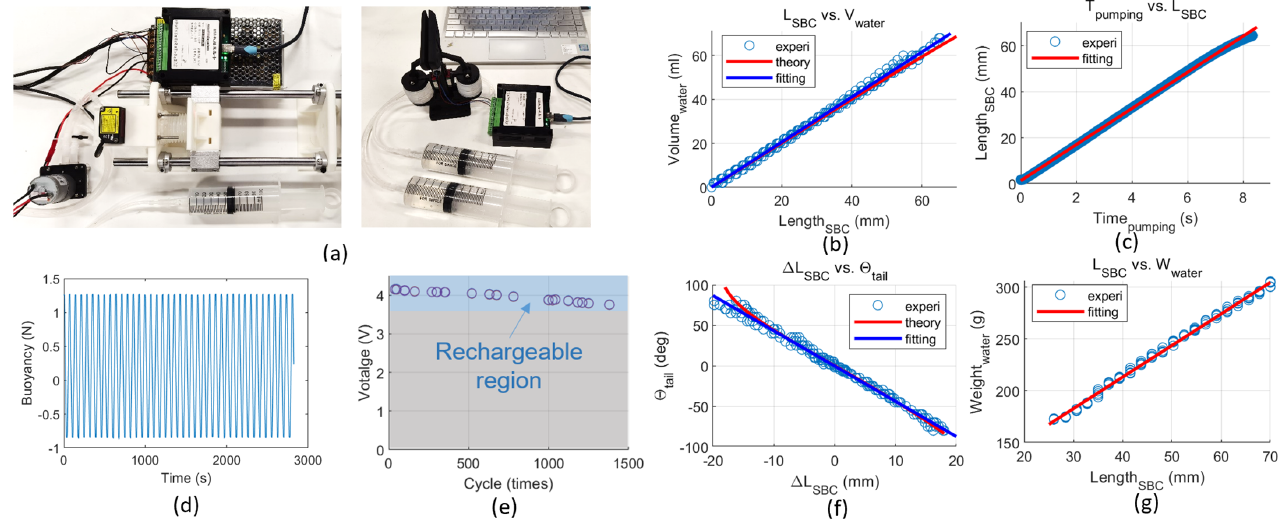
Figure 5. Bench test results, with the test apparatus, energy consumption test, and SBC actuator test results, as well as the tail MCM-II test, shown. ( a ) Bench test apparatuses. The left one is used to explore the relationship between the length of the SBS (L SBC ) and volume of the contained water (V water ), pumping time (T pumping ), and weight of the contained water (W water ). The results are shown in subfigures ( b ), ( c ), and ( g ), respectively. The right one was used to explore the relationship between the change of the length of SBC ( ∆ L_SBC) and rotation angle of the tail ( θ tail ), and the result is shown in subfigure ( f ). During the endurance test, the buoyancy states of the gilder were recorded timely and shown as the subfigure ( d ). The voltage of the Li–Po battery is also recorded and shown as the subfigure ( e ). Besides, the different colors in ( e ) represents the different times of the tests.